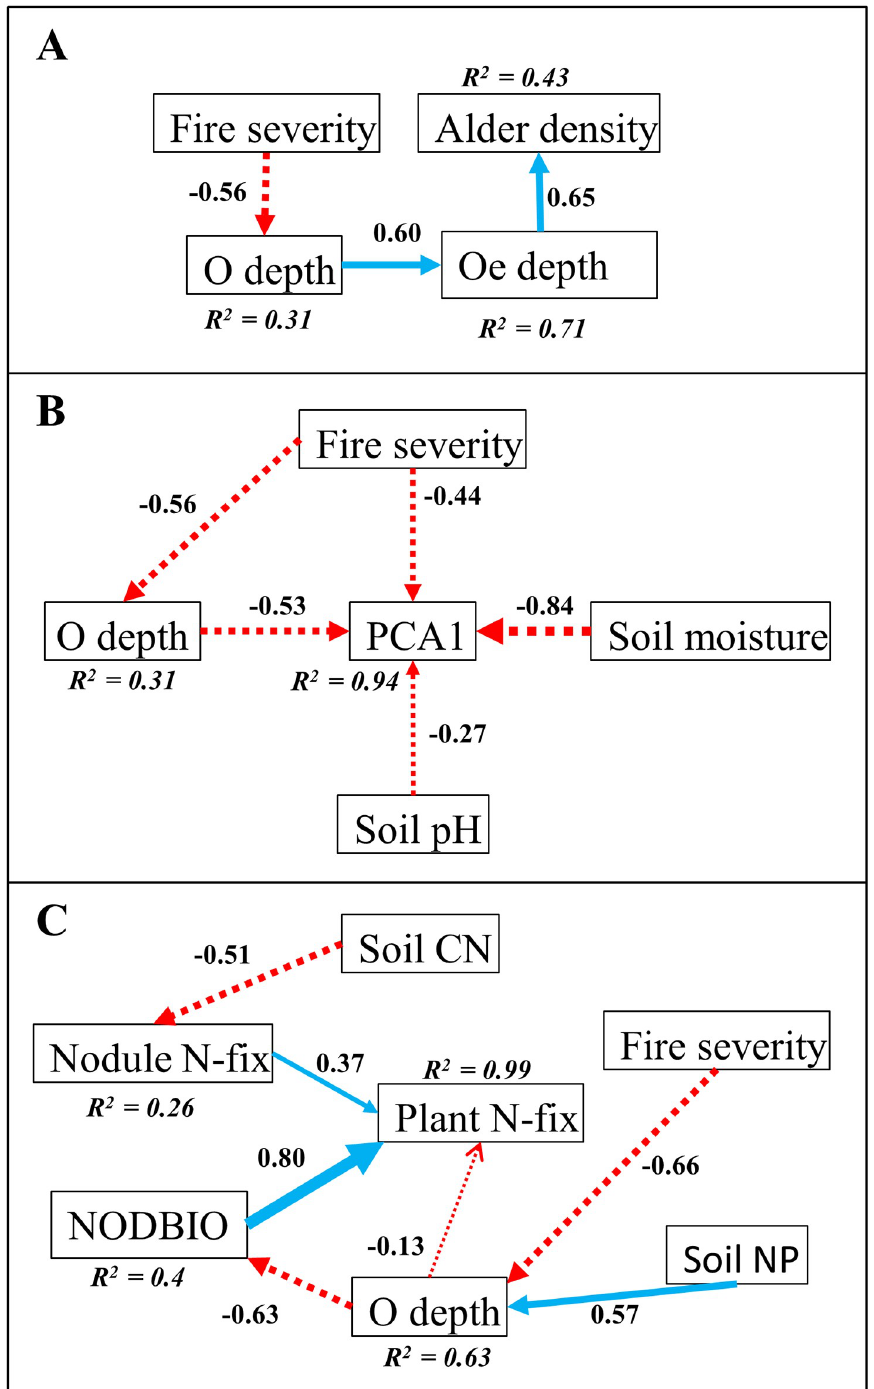
Fig 2. Structural equation model of A) Siberian alder density (plants ha -1 ), B) PCA1 [plant-level live nodule biomass (+), mean ramet height (+), mean ramet diameter (+), and specific leaf mass (-)], and C) Plant N-fix [annual plant-level N-fixation input (g N m -2 plant -1 yr -1 )] in post-fire black spruce dominant plots of the Boundary Fire (n = 11). Fire severity = difference in normalized burn ratio (dNBR), O depth = depth of organic horizon, Oe depth = depth of hemic layer, Soil pH = mineral horizon pH, Soil moisture = moisture in organic horizon, Soil CN = mineral horizon C:N ratio, Nodule N-fix = nodule-level N-fixation rate ( μ mol N g nodule -1 hr -1 ),